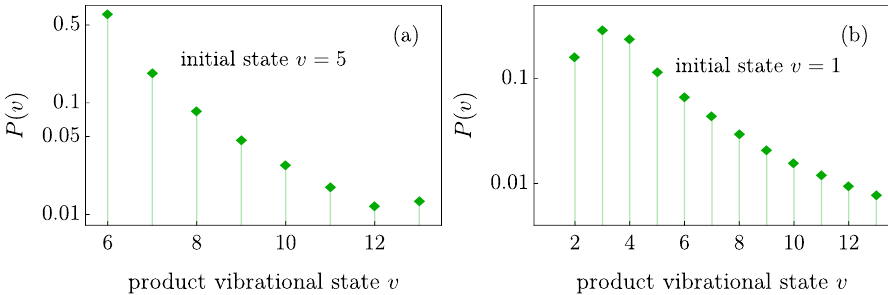
Figure 5. ( a ) Distribution of product states for vanishing collision energy after the inelastic collision for the 5th vibrational state ( v = 5). ( b ) Same, but for the most weakly bound state ( v =